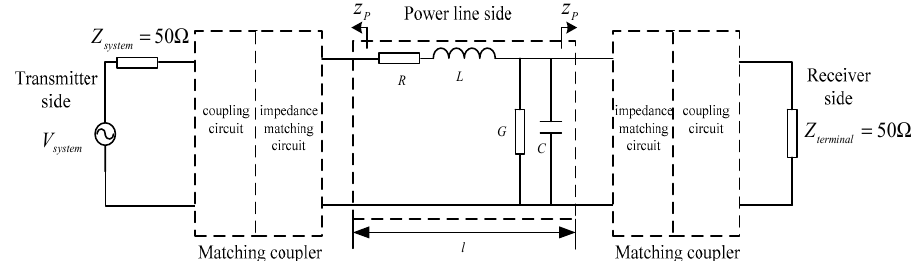
Figure 1. PLC coupler composed of coupling circuit and impedance matching circuit [64].